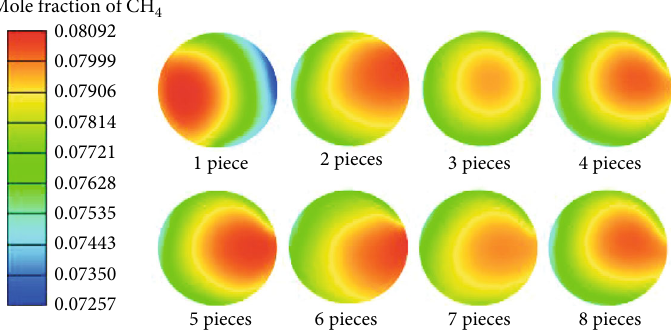
Figure 9: In fl uence of the number of spiral blades in the tubule zone on the uniformity.